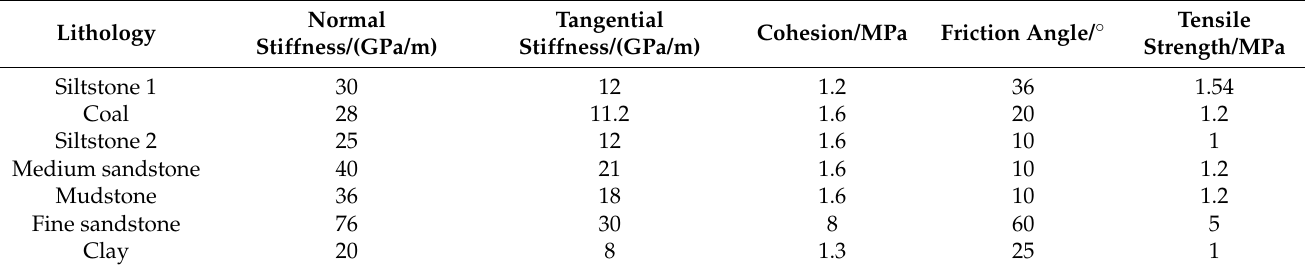
Table 2. Micro-parameters of the